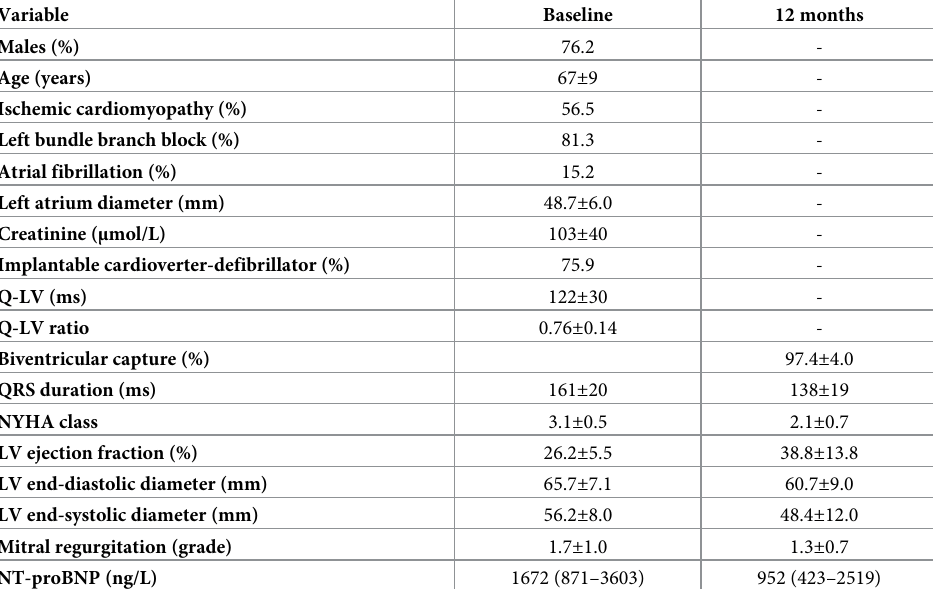
Table 1. Baseline and 12-month characteristics of study population (N =